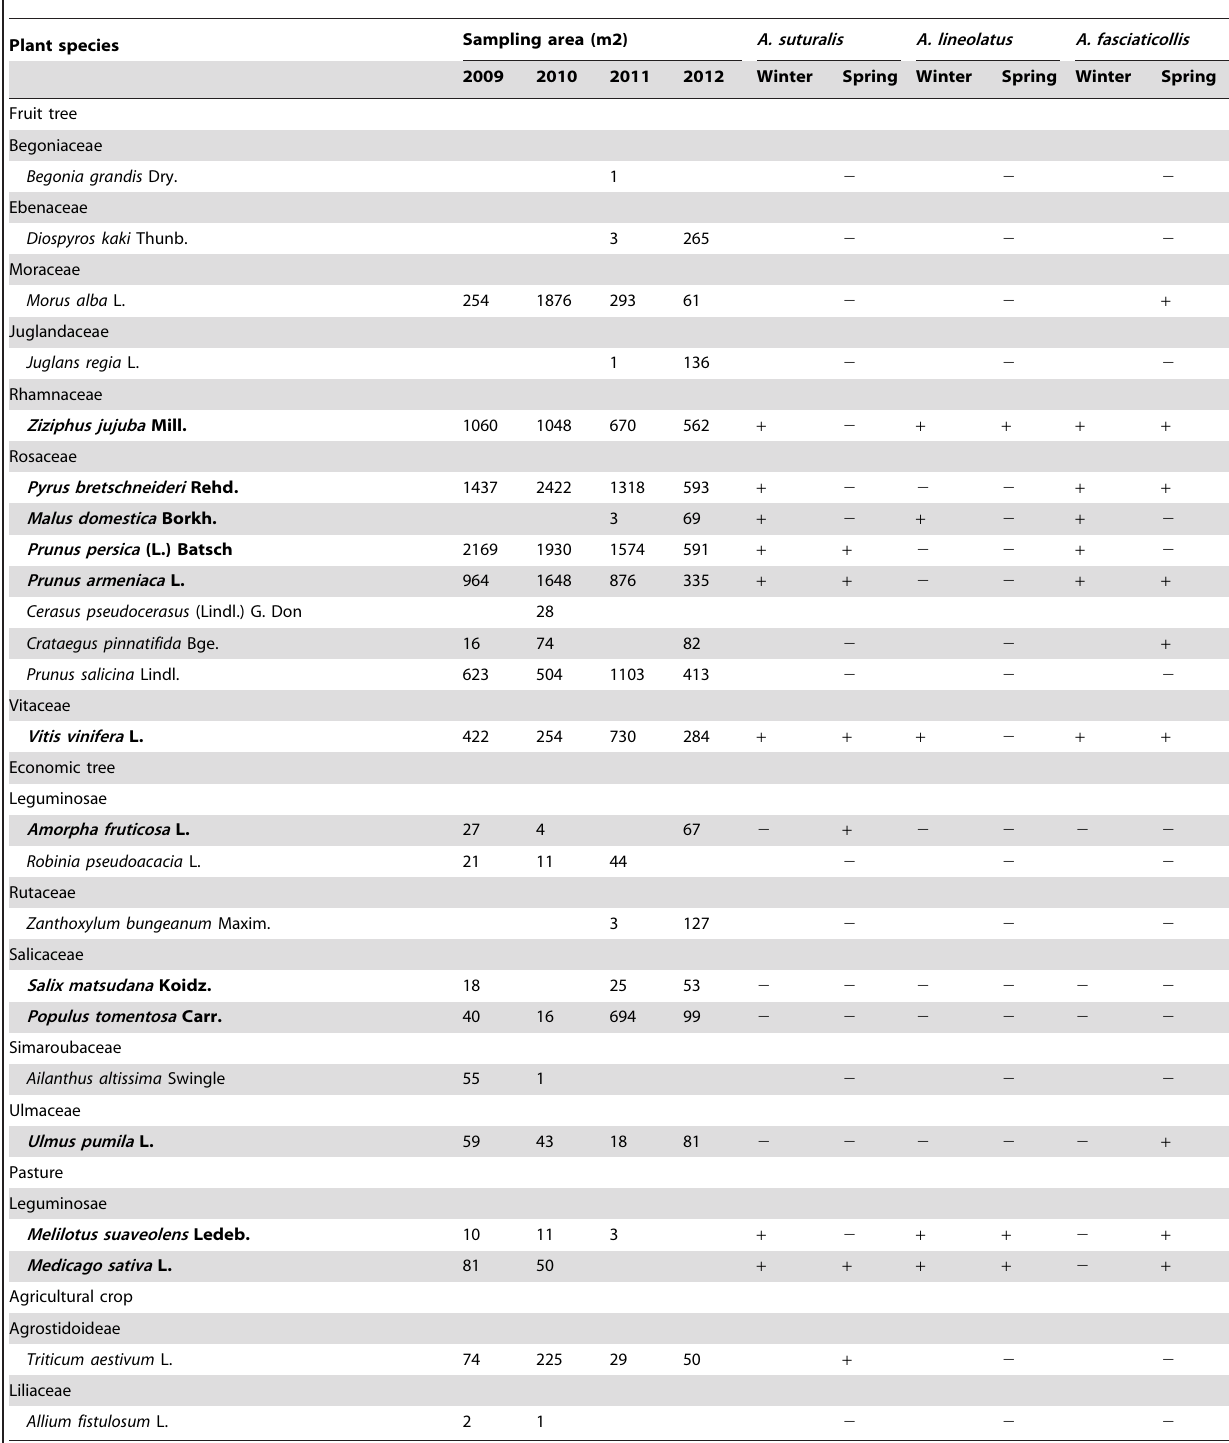
Table 2. Cultivated host plants of Adelphocoris spp. in the spring and the winter during 2009–2012 at Langfang, Hebei Province, China.